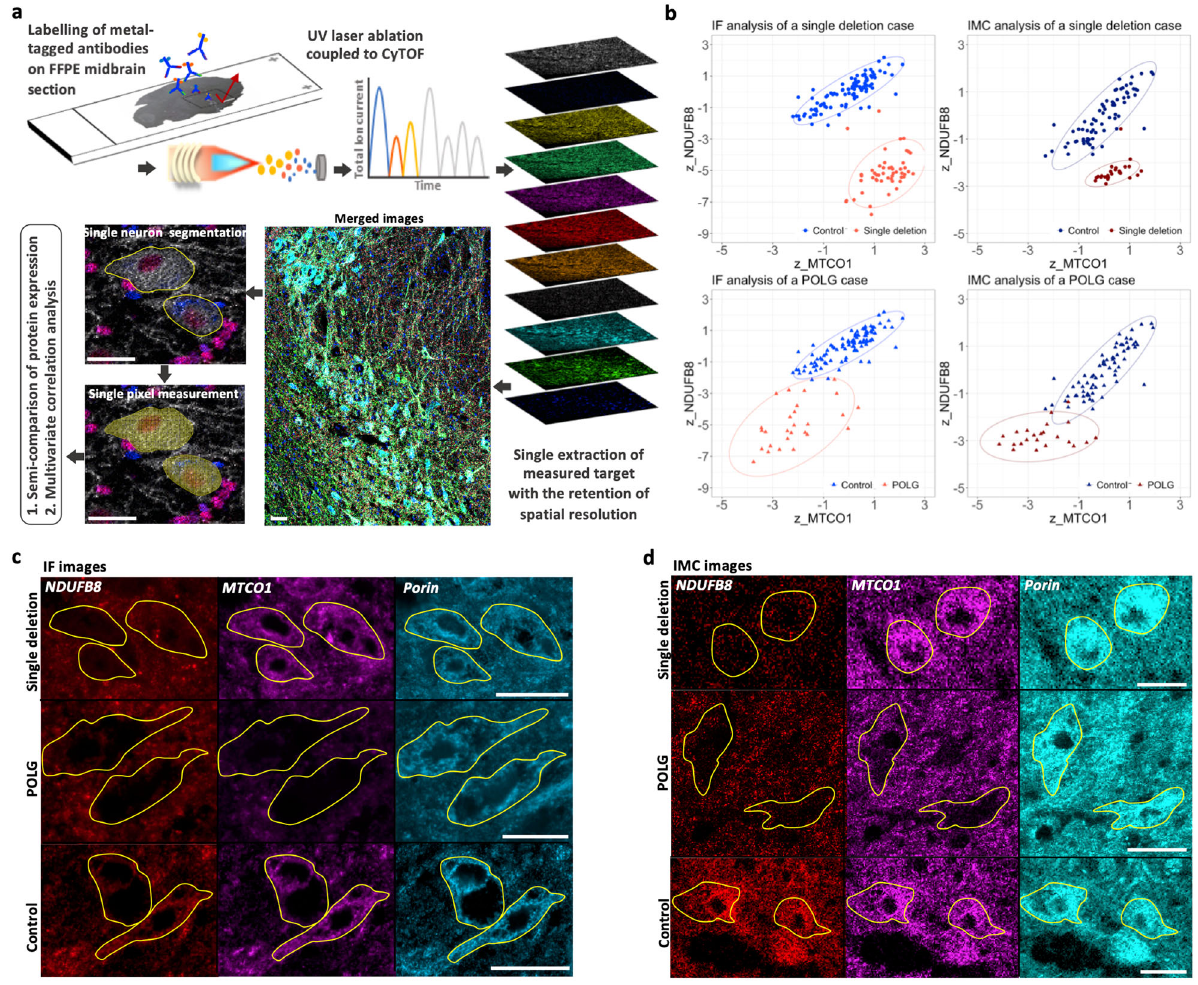
Fig. 1 Work fl ow and validation of imaging mass cytometry (IMC) assay on human post-mortem midbrain. a A schematic demonstration of the IMC experimental work fl ow to investigate protein expression in individual midbrain neurons . Formalin- fi xed, paraf fi n-embedded (FFPE) midbrain sections (5 µm) were immuno-labelled with twelve Lanthanide-metal-conjugated antibodies. Regions of interest within the substantia nigra (SN) region were ablated under a pulsed 213 nm UV laser beam, ionised and accelerated via an inductively coupled plasma source (ICP) of the “ cytometry by time of fl ight ” (CyTOF). Ion currents from each metal tag were detected as a signal intensity, re fl ecting the abundance of speci fi c target proteins and assembled with spatial information into images. Individual tyrosine hydroxylase (TH)-positive dopaminergic neurons were manually outlined, with the single pixels within each outline automatically segmented. The mean signal intensity for only the cytoplasmic pixels per outlined neuron was calculated for further statistical analysis. b Validation of IMC pro fi ling of mitochondrial oxidative phosphorylation (OxPhos) protein expression in the SN neurons by comparison to immuno fl uorescent (IF) data. Neurons from a mitochondrial disease case harbouring a single, large-scale mitochondrial DNA (mtDNA) deletion (red; female, 40 years) previously found to have an isolated complex I de fi ciency, and a patient with POLG mutations (dark red; male, 59 years, POLG03 in the cohort) which showed de fi ciencies in both complex I and IV (Chen et al 7 .). The z score data for complex I (z_NDUFB8) and complex IV (z_MTCO1) expression (normalised to VDAC1 expression) generated from both IF and IMC were plotted and compared to the same control cases (blue; 66 years and 73 years, male) respectively. The 95% con fi dence ellipse was also illustrated for each dataset. c , d Example images from IF and IMC. Individual neurons (outlined) negative for NDUFB8 and positive for MTCO1 from the single deletion case, are shown alongside neurons negative for both NDUFB8 and MTCO1 in the patient with POLG mutations, and both signals were normal in neurons from the control cases. Scale bar, 50